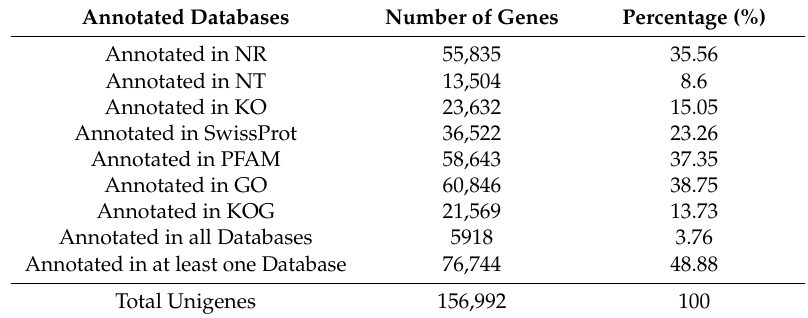
Table 2. Summary of the function annotation results for H. pluvialis unigenes in public protein databases.